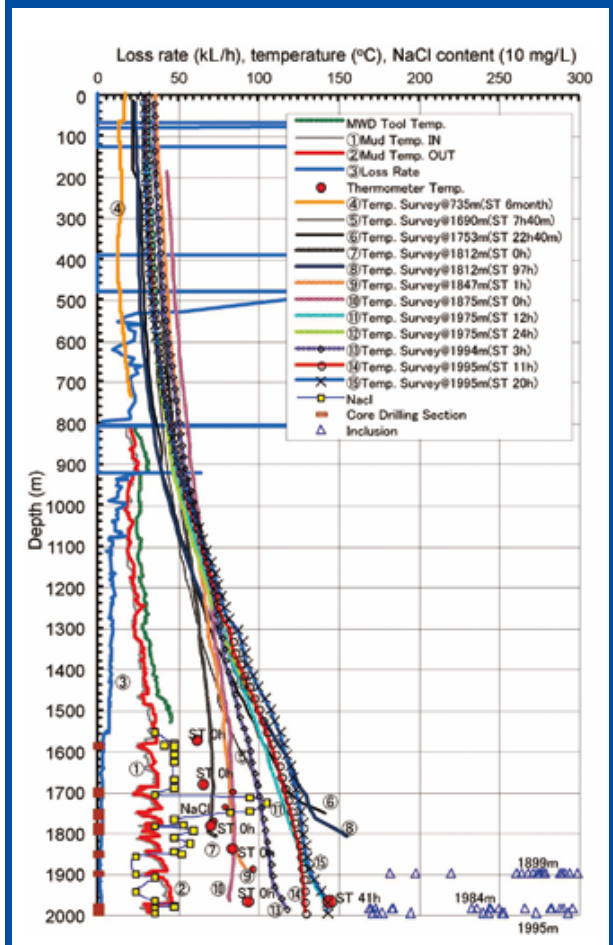
Figure 6. Profiles of temperature measured during drilling. Loss rate of mud circulation and NaCl content, calculated with mud chemistry, are also shown. Lost circulation became smaller as the depth increased and was minimum in the conduit zone (deeper than 1500 m). Values of the homogenization temperature for fluid inclusions in plagioclase crystals are also shown in the conduit zone. The minimum values are close to the highest temperatures during drilling. ST is standing time. NaCl contents are highest in the middle of the conduit zone (around 1750